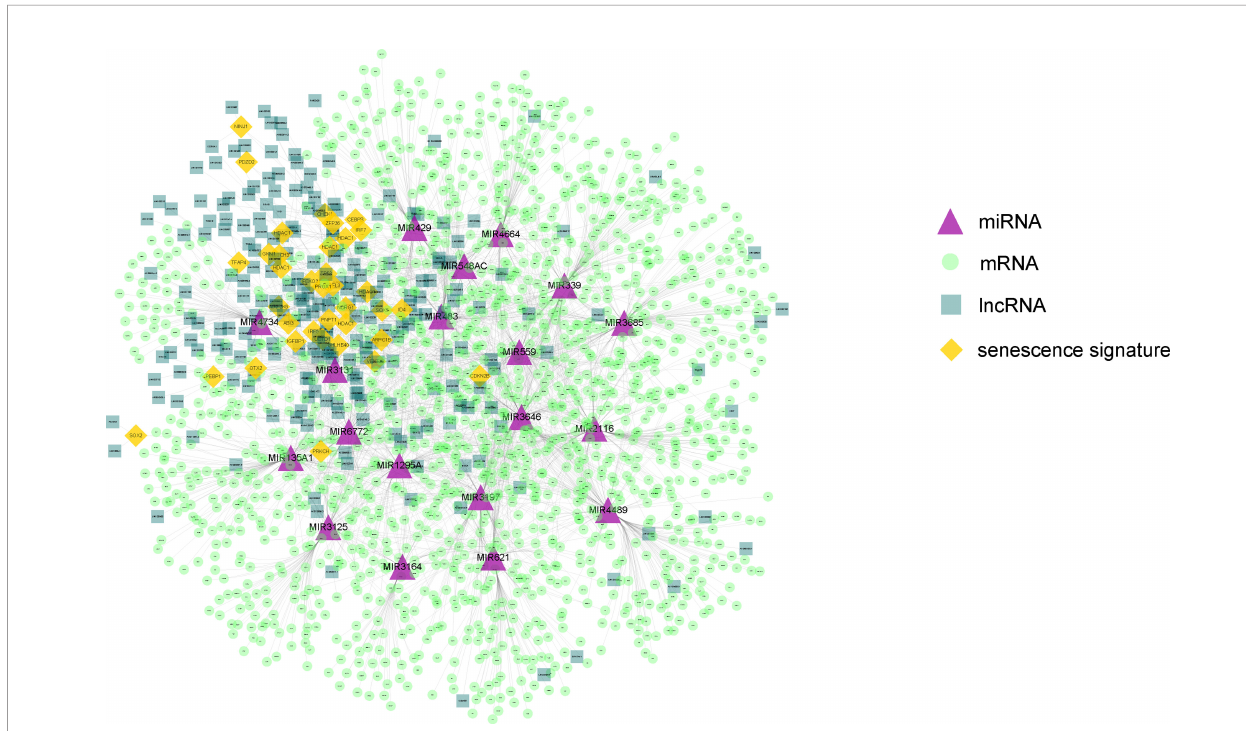
FIGURE 3 | The constructed ceRNA network using differentially expressed genes between the two HCC subtypes. The network contained 39 senescence signatures, 235 lncRNAs, 19 miRNAs, and 1,546 mRNAs regulated by non-coding RNAs. The purple triangle represents miRNAs. The yellow diamond represents senescence signatures. The light green circle represents mRNAs regulated by non-coding RNAs. The dark green square represents differential expressed lncRNAs. The orange diamond represents senescence